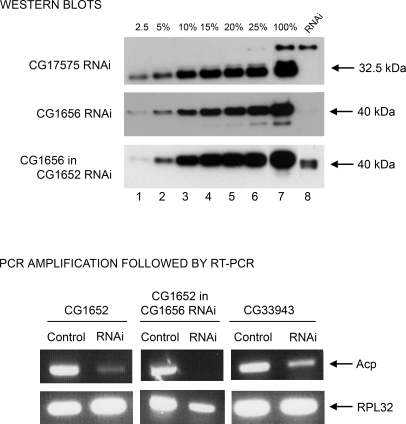
Example Western Blots and RT-PCR Showing the Levels of Acps in Knockdown Males (RNAi) Compared to Control MalesIn western blots, the extents of Acp knockdowns were quantified by running serial dilutions to the level of 2.5% (lane 1), 5% (lane 2), 10% (lane 3), 15% (lane 4) 20% (lane 5), 25% (lane 6) and 100% (lane 7) of accessory gland proteins from control males in parallel with accessory gland proteins equivalent to the amount in one knockdown male (RNAi). Two independent sets of samples were analyzed to confirm the level of knockdown. Additional multiple nonquantitative westerns were carried out on these lines to confirm their knockdown prior to each assay. Knockdowns were specific to the targeted Acp except for the related C-type lectins (CG1652 and CG1656). RNAi of CG1652 also knocks down CG1656, as shown. Similarly, knockdown of CG1656 knocks down CG1652; an example is shown using RT-PCR. For PCR amplification, cDNA prepared from RNA extracts of 20 control males or experimental males was used. RPL32 primers [30] were used as positive control for the quality/quantity of cDNA. The panel on the extreme right in the “RT-PCR” panel represents an example of knockdown specific to the targeted Acp (CG33943). We observed similar results for all other Acps tested either by western or RT-PCR (unpublished data).